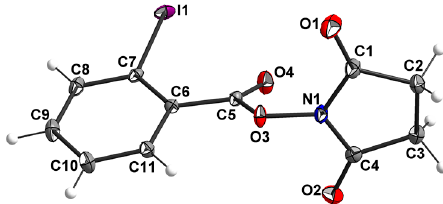
Figure 3. The molecular structure of 3e with the atom labeling scheme. Displacement ellipsoids are drawn at the 50% probability level.